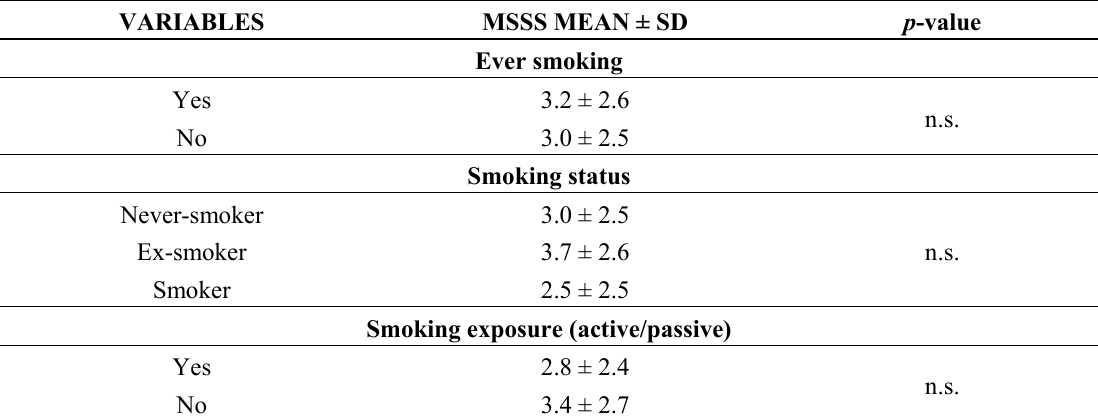
Table 3. Smoking habits and MS severity (MSSS mean value ± standard